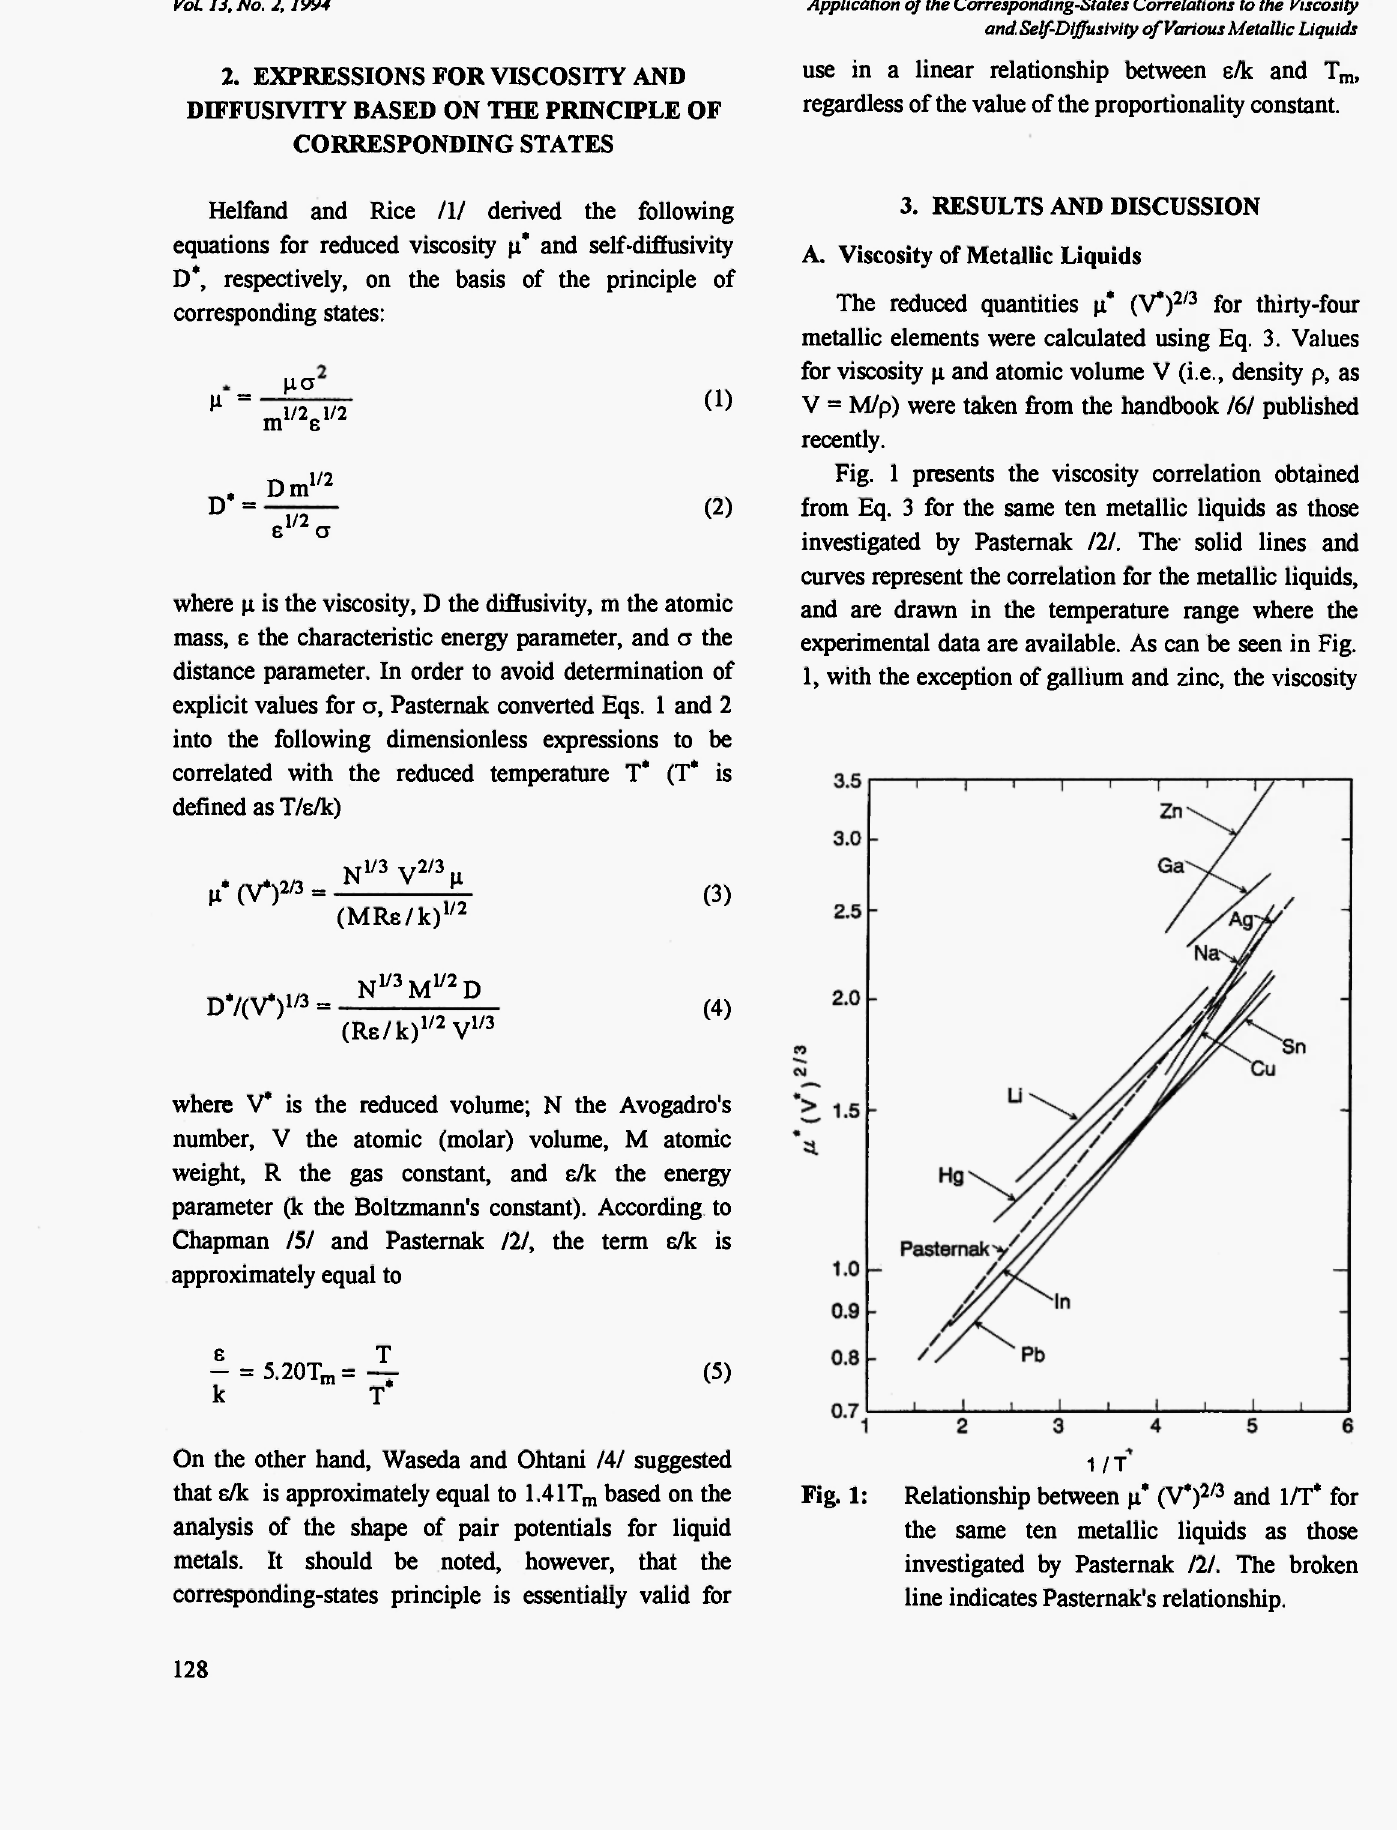
Fig. 1: Relationship between μ* (V*) 2/3 and 1/T* for the same ten metallic liquids as those investigated by Pasternak 111. The broken line indicates Pasternak's